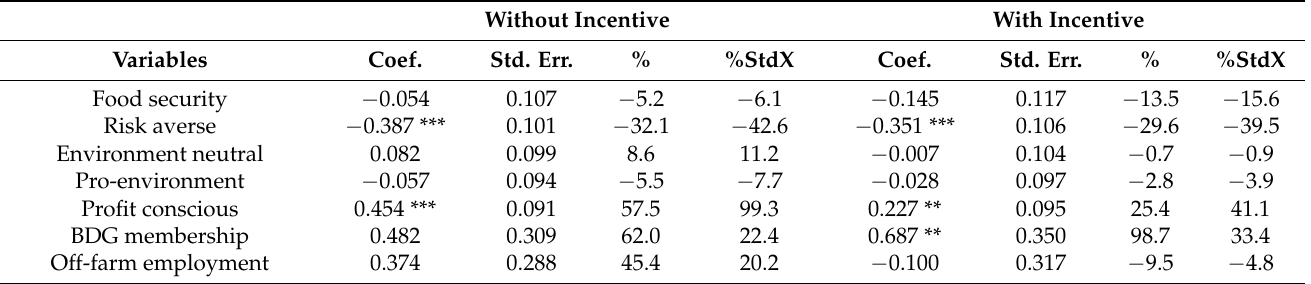
Table A1. Estimates of determinants of intention to adopt long-term land leasing for lessee (N = 409). Without Incentive With Incentive Variables